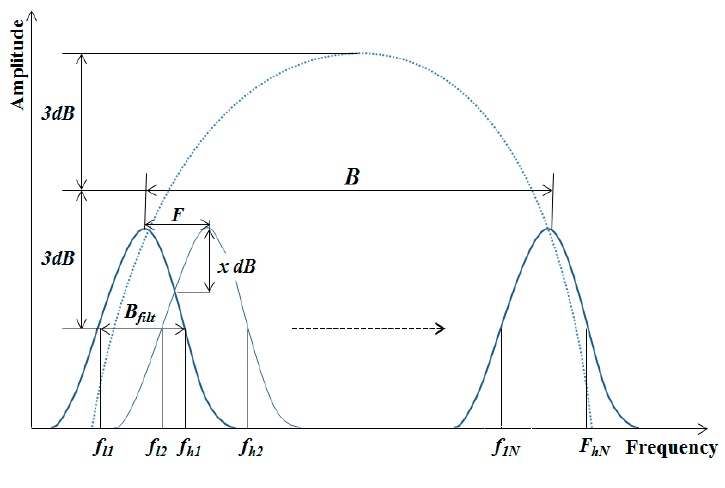
Figure 3. SSP filter design.